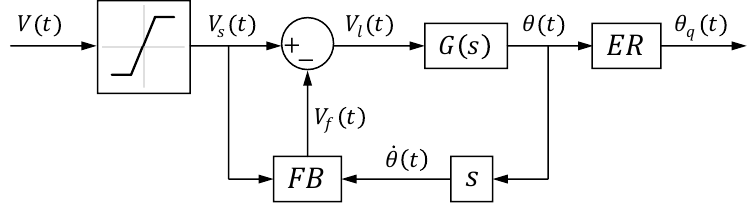
Figure 5. Complete motor model